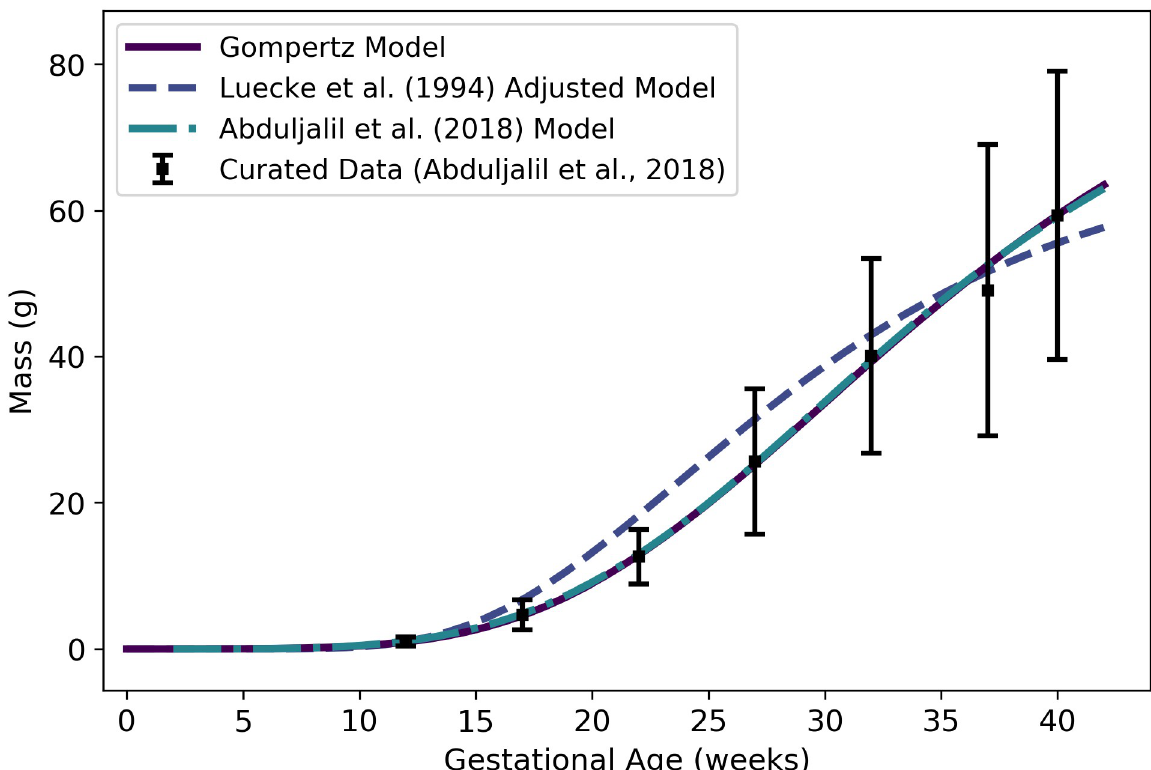
Fig 18. Fetal lung mass vs. gestational age. The Gompertz model (solid line) given by Eq 37 was selected as the most parsimonious model in our analysis. The model of Luecke et al. [15], which is a power law model based on fetal mass, was calibrated using a different data set [25]. The version of the Luecke et al. [15] model depicted here has been adjusted as described in the text. Note that our Gompertz model and the model of Abduljalil et al. [33] are virtually indistinguishable in this plot.